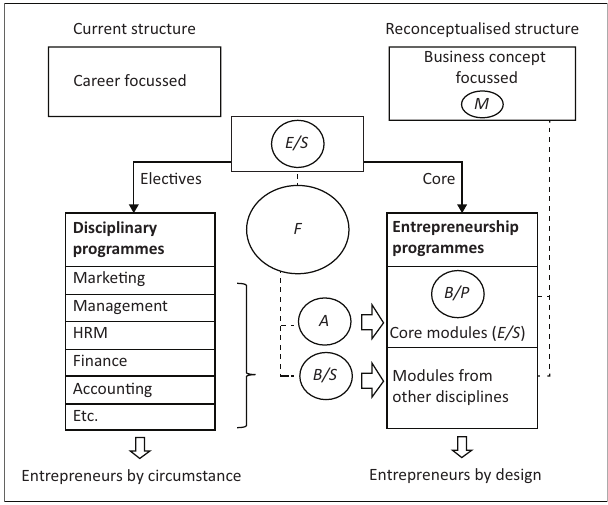
FIGURE 1: Reconceptualised framework for entrepreneurship